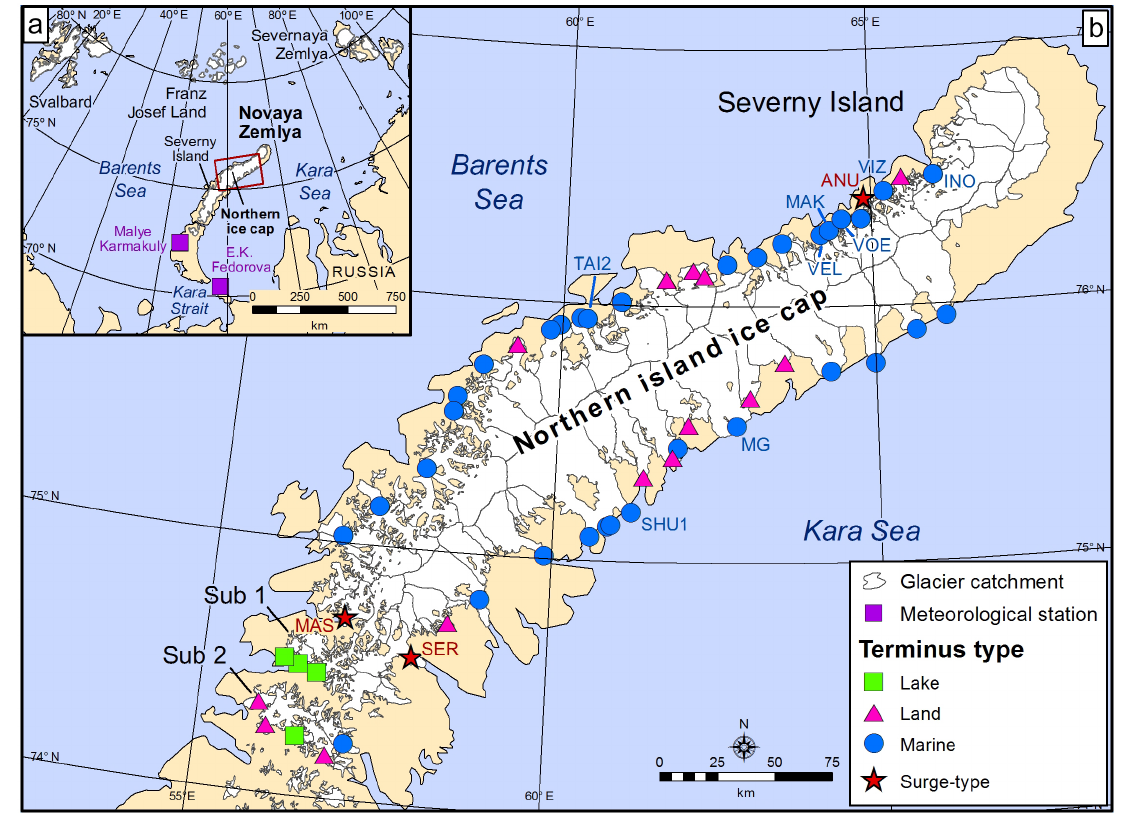
Figure 1. Location map, showing the study area and outlet glaciers. (a) Location of Novaya Zemlya, in relation to major land and water masses. Meteorological stations where air temperature data were acquired are indicated by a purple square (Malye Karmakuly, WMO ID: 20744; E. K. Fedorova, WMO ID: 20946). (b) Study glacier locations and main glacier catchments (provided by G. Moholdt and available via GLIMS database). Glaciers are symbolized according to terminus type: marine-terminating (blue circle); land-terminating (pink triangle); lake-terminating (green square); and observed surging during the study period (red star). Glaciers observed to surge are Anuchina (ANU), Mashigina (MAS), and Serp i Molot